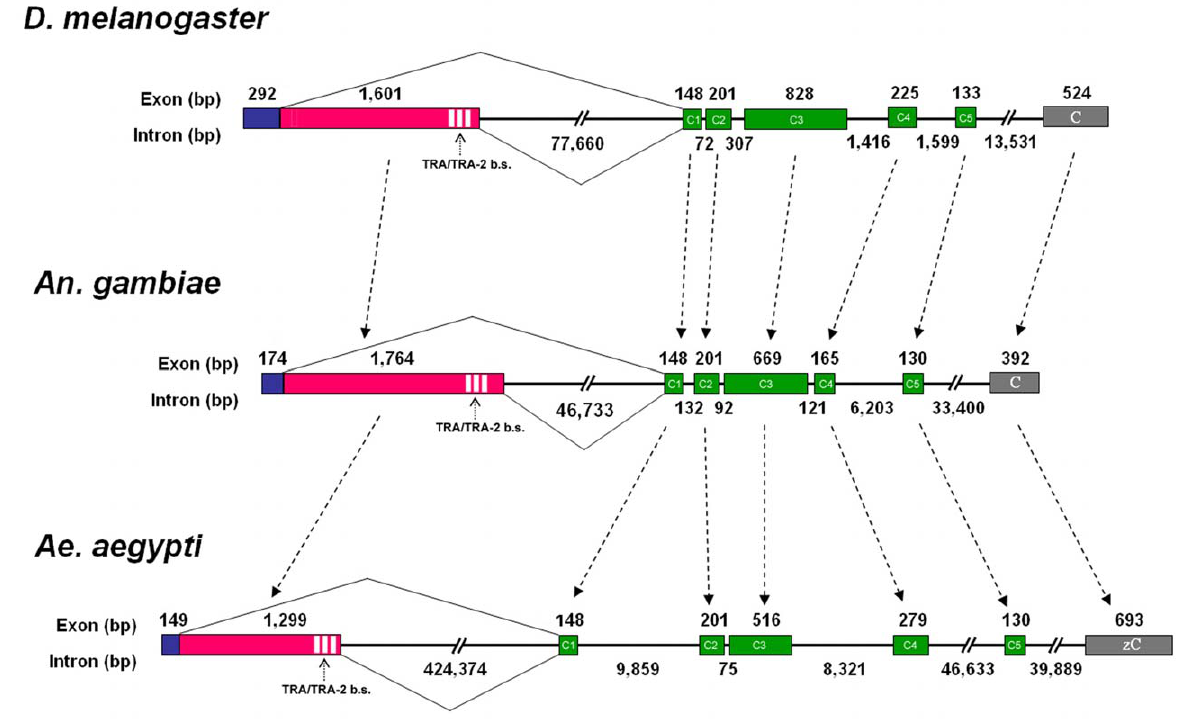
Figure 3. Comparative scheme of D.melanogaster , Ae.aegypti and An.gambiaefru -P1 genomic structure. Due to its complex structure, with multiple promoters and 5 9 and 3 9 alternative splicing, we compare the homologous portion of fru genes, starting with the sex-specific regulated region and ending with the ZnF-C domain encoding exon. fru -P1 common (but encoding the male-specific N-terminus) and female-specific exons are represented as blue boxes and pink boxes, respectively. Green boxes represent the non-sex-specific exons encoding BTB domain and connector region of FRU proteins while terminal grey boxes represent the ZnF-C domain encoding exons. White rectangles represent TRA/TRA-2 binding sites. The Drosophila fru corresponding region spans 98 Kb and is organized in 7 exons and 6 introns, with 6 common exons, preceded by the sex-specific regulated region with a male-specific and a female-specific exons. Dmfru MC translation initiates at the ATG within exon P1-m and terminates within the ZnF-C encoding exon C, while in the case of Dmfru C translation initiates at the ATG within the BTB encoding exon C1 and terminates within at the same stop signal in exon ZnF-C.